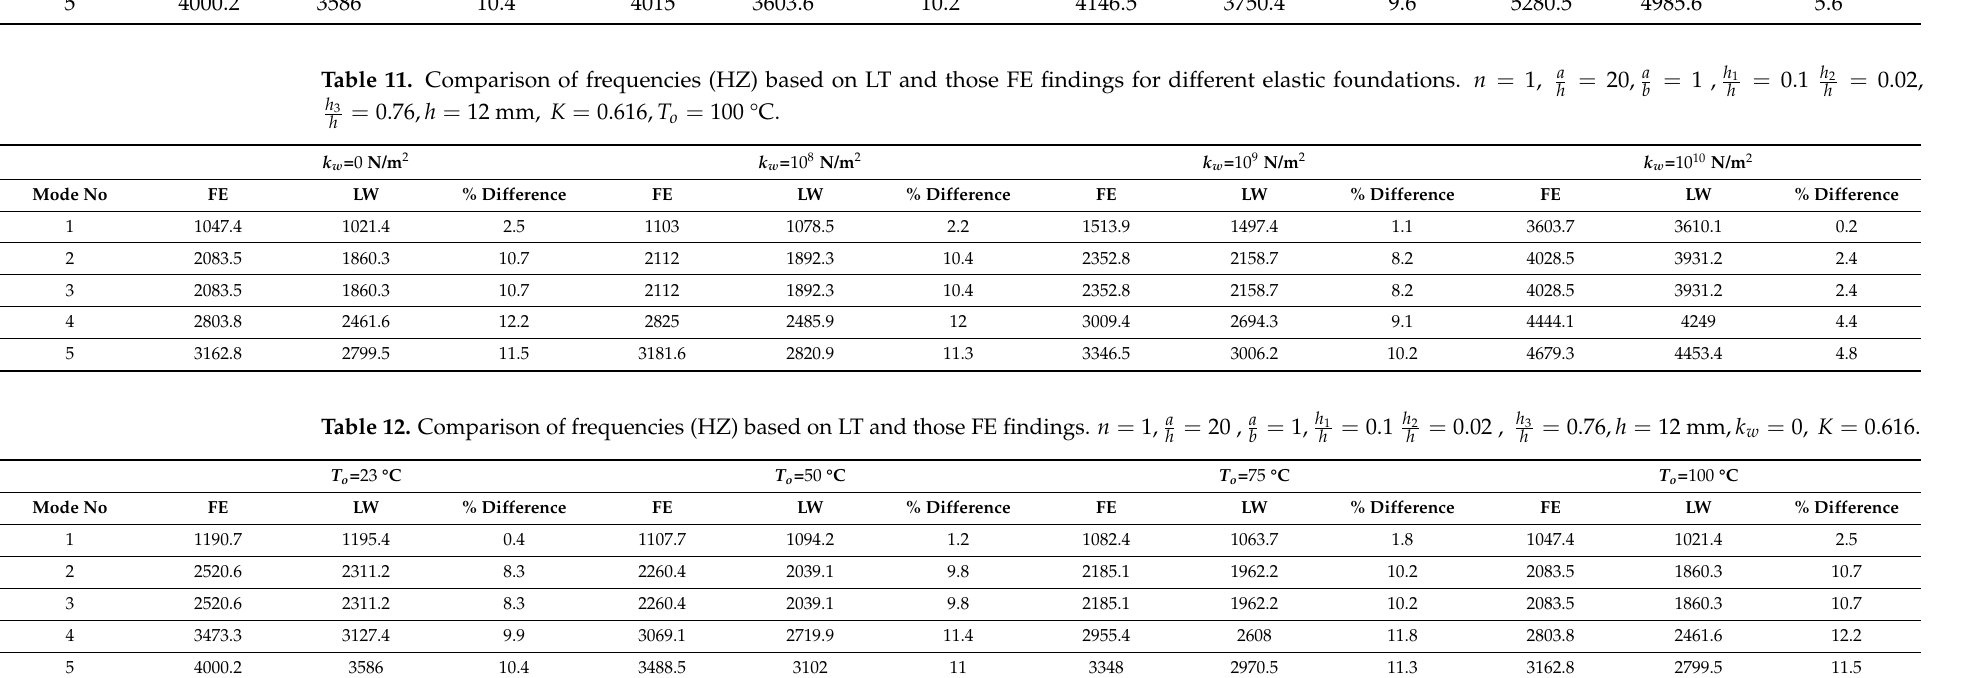
= 20, a = 1 , h 1 = 0.1 h 2 = 0.02, h b h h